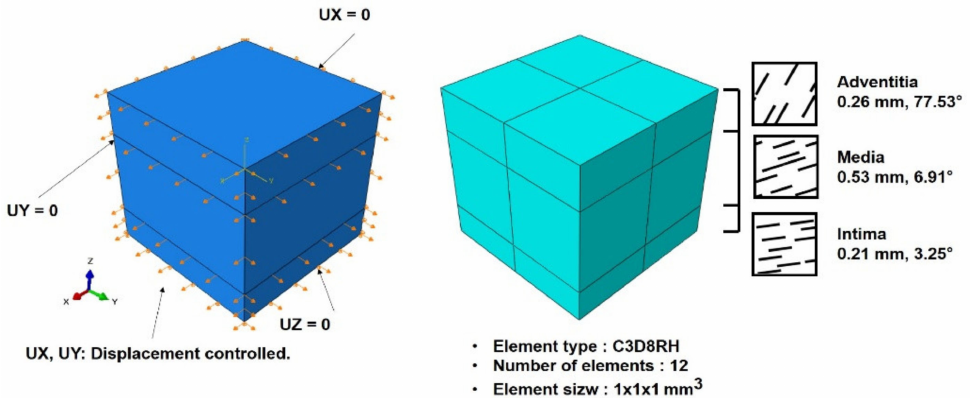
Figure 1. Representative volume element (RVE) model and loading boundary condition for simula- tion. Fiber orientation was set counterclockwise from the axial direction.